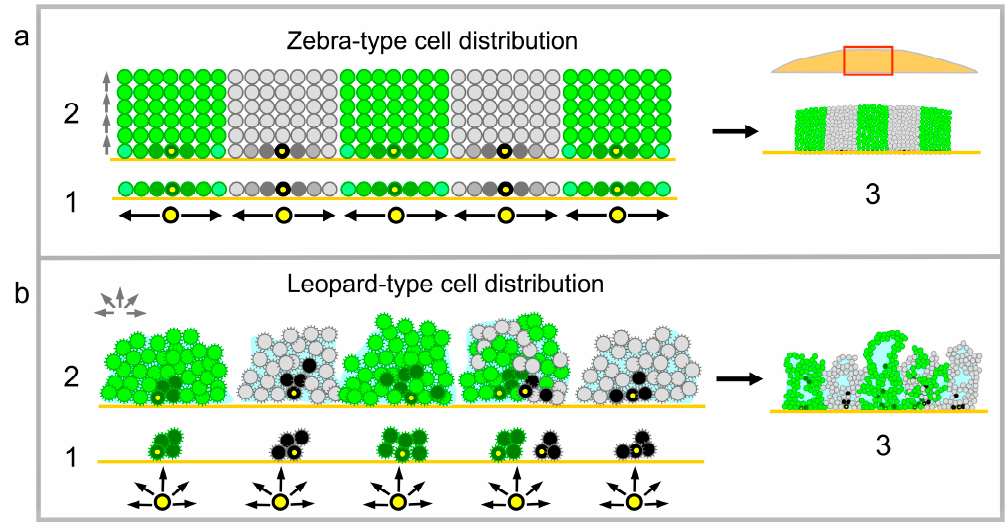
Figure 5. Model of cell distribution during the formation of colonies ( a ) and colony biofilms ( b ). Schematic view on cross-sections of young chimeric giant colony (about 12 h old) or colony biofilm (about 4-h-old) (1); 24-h-old (2); and 3-day-old (3) structures. Black and gray cells show old and younger black cells, respectively, dark and light green show old and younger green cells, respectively. For 1 in a, the lighter the color of the cell, the younger the cell. Original inoculated cells are marked in yellow. Red rectangle in a / 3 shows the localization of green / black schematic within the whole colony cross-section. Black and green arrows indicate the direction of cell growth in 1 and in 2; light blue, ECM; cell surface brushes in ( b ), adhesive fibers.